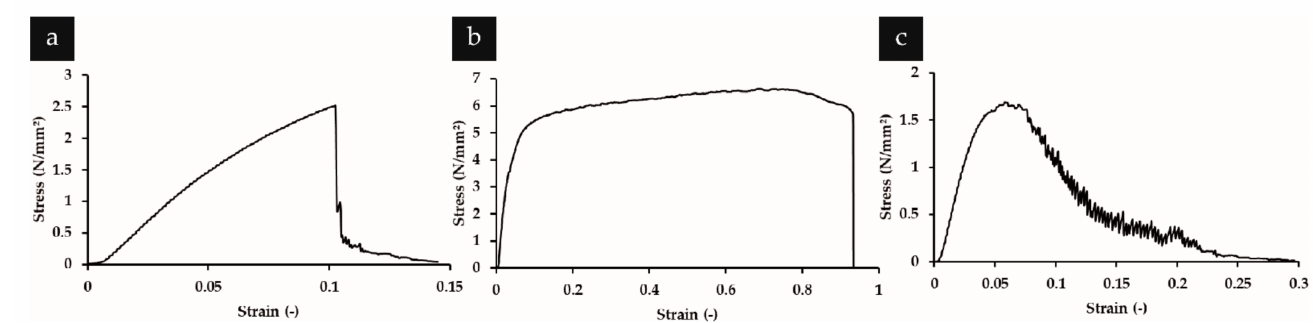
Figure 7. Typical stress–strain curve of ( a ) eADF4(C16), ( b ) PAN, and ( c ) cellulose acetate